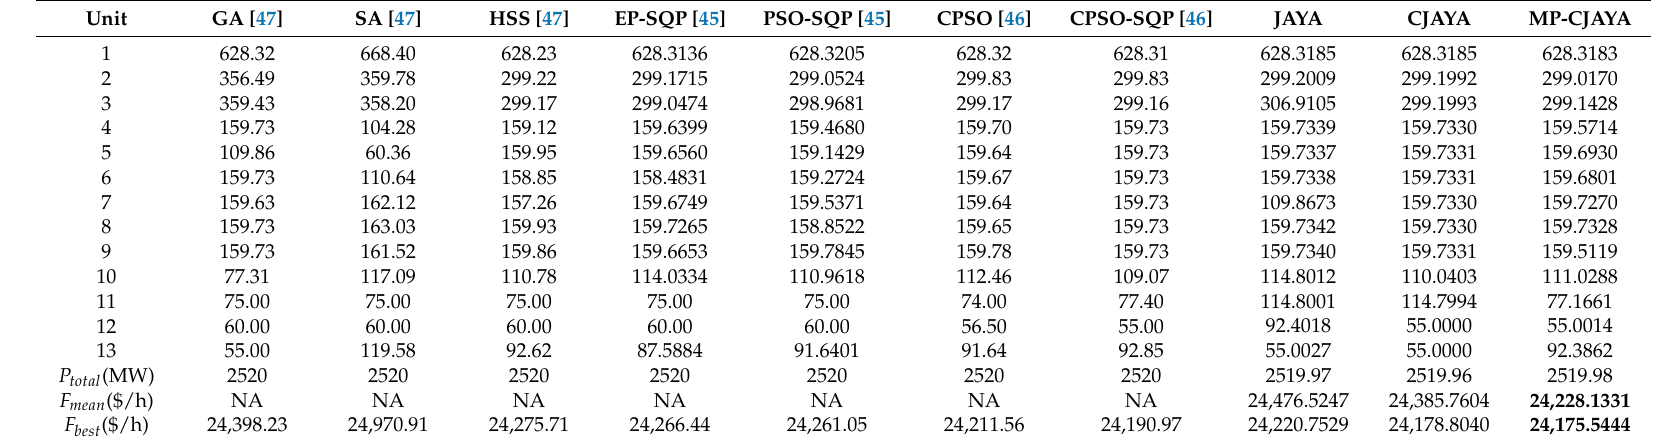
Table 3. Best outputs for 13-units system ( P D = 2520